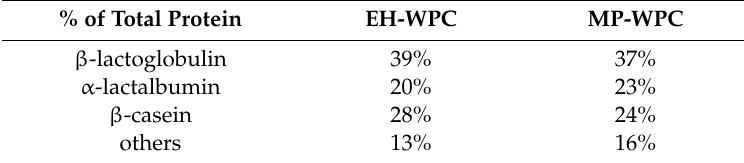
Table 1. Protein composition of the Whey Protein Concentrate (WPC). % of Total Protein EH-WPC MP-WPC β -lactoglobulin 39% 37% α -lactalbumin 20% 23% β -casein 28% 24% others 13% 16% The percentage of specific casein and whey proteins in WPC at pH 7.1, determined by sodium dodecyl sulfate polyacrylamide gel electrophoresis (SDS-PAGE) analysis. EH-WPC = extensively heated whey protein concentrate, MP-WPC = mildly pasteurized whey protein